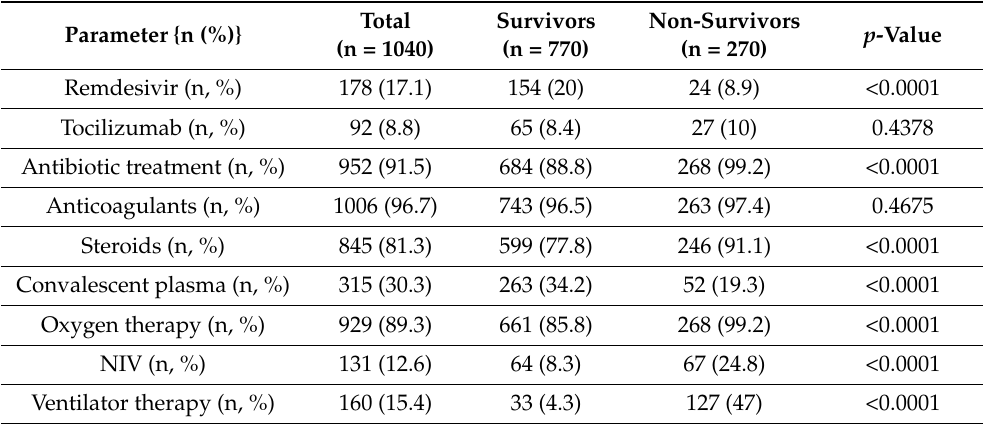
Table 3. Treatment in both groups.